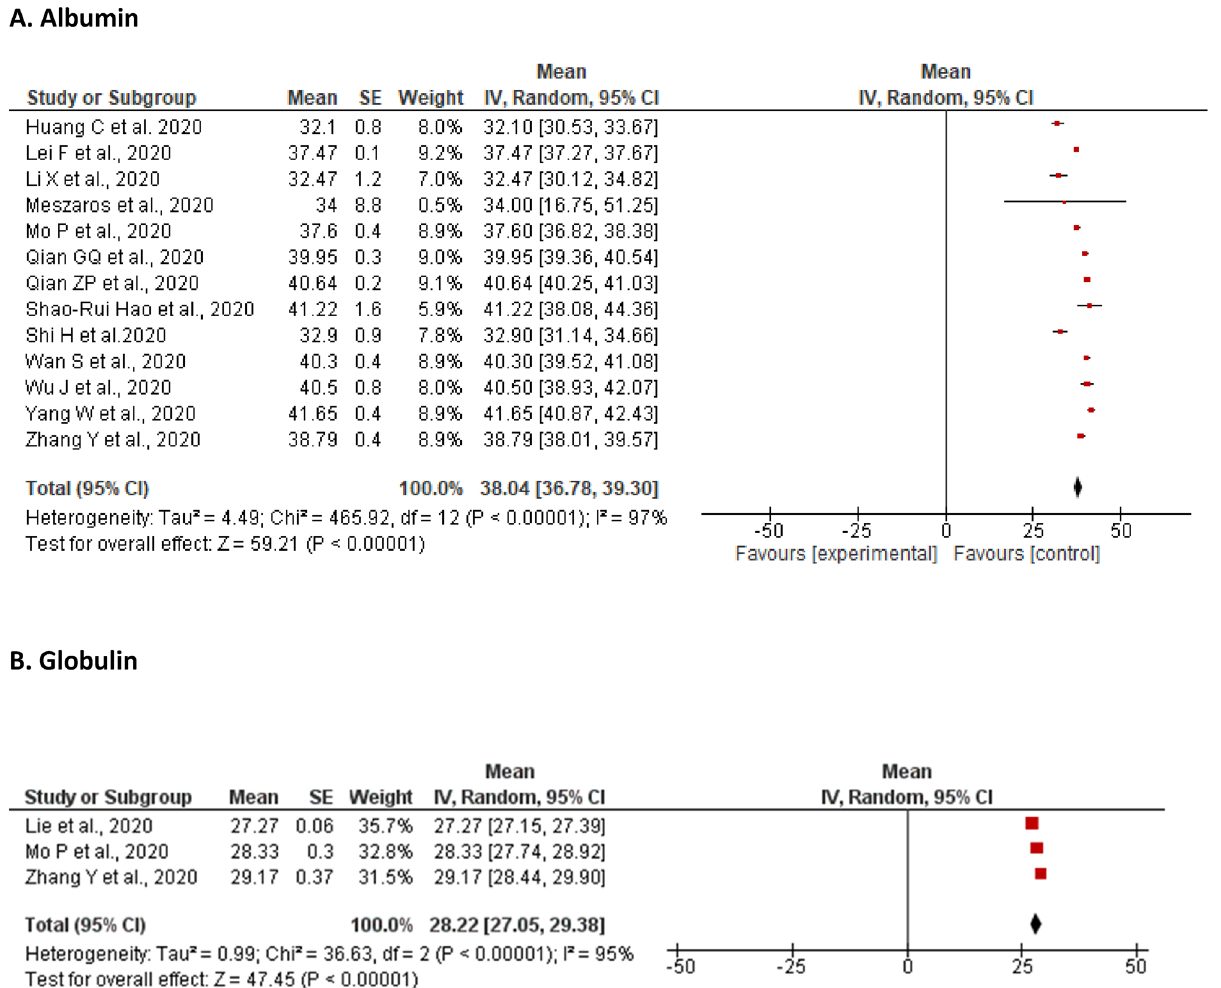
Figure 2. Meta-analyses of the pooled mean of Liver enzymes. ( A ) Albumin; ( B ) Globulin; ( C ) Alanine aminotransferase; ( D ) Alkaline phosphatase; ( E ) Aspartate aminotransferase; ( F ) Gamma-glutamyl